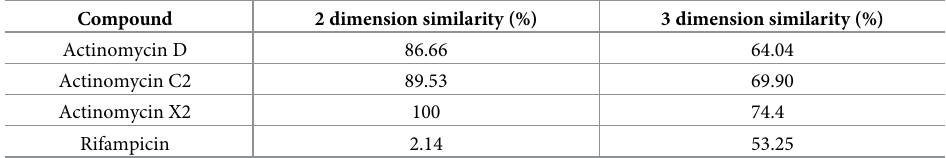
Table 1. Resemblance of Transitmycin with other closer